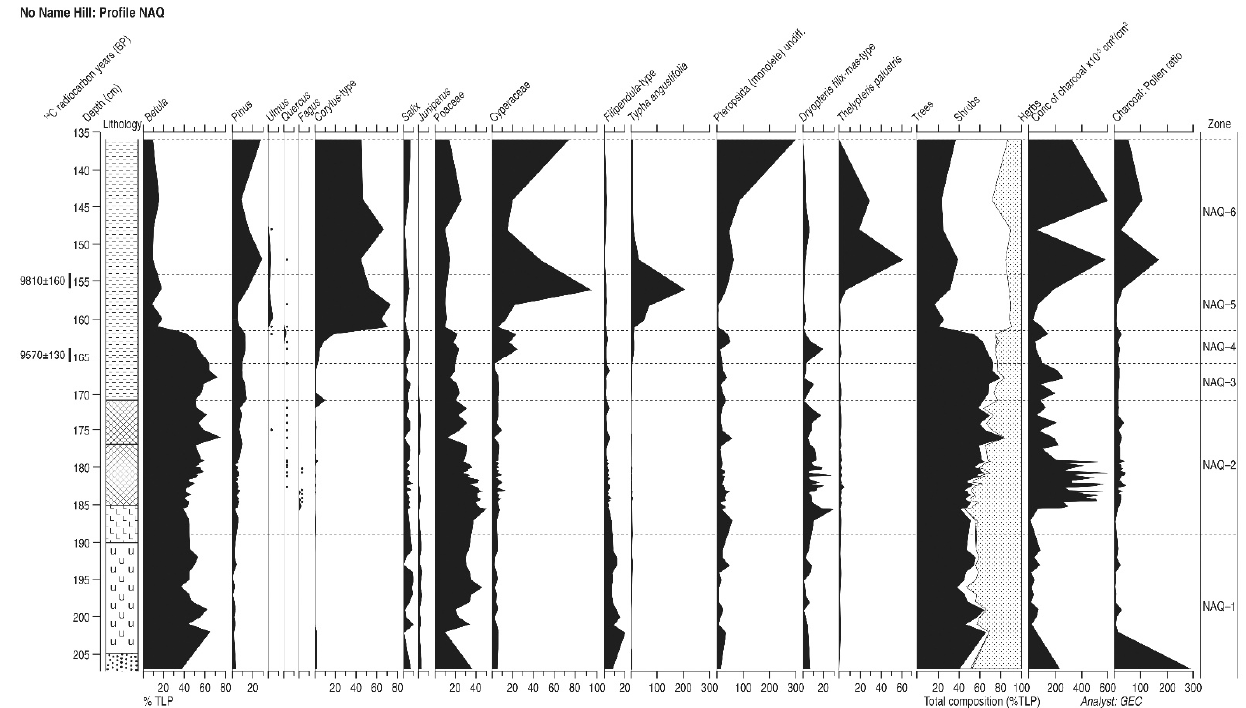
Figure 4. Percentage pollen diagram from No Name Hill profile NAQ. (Analysis GEC).